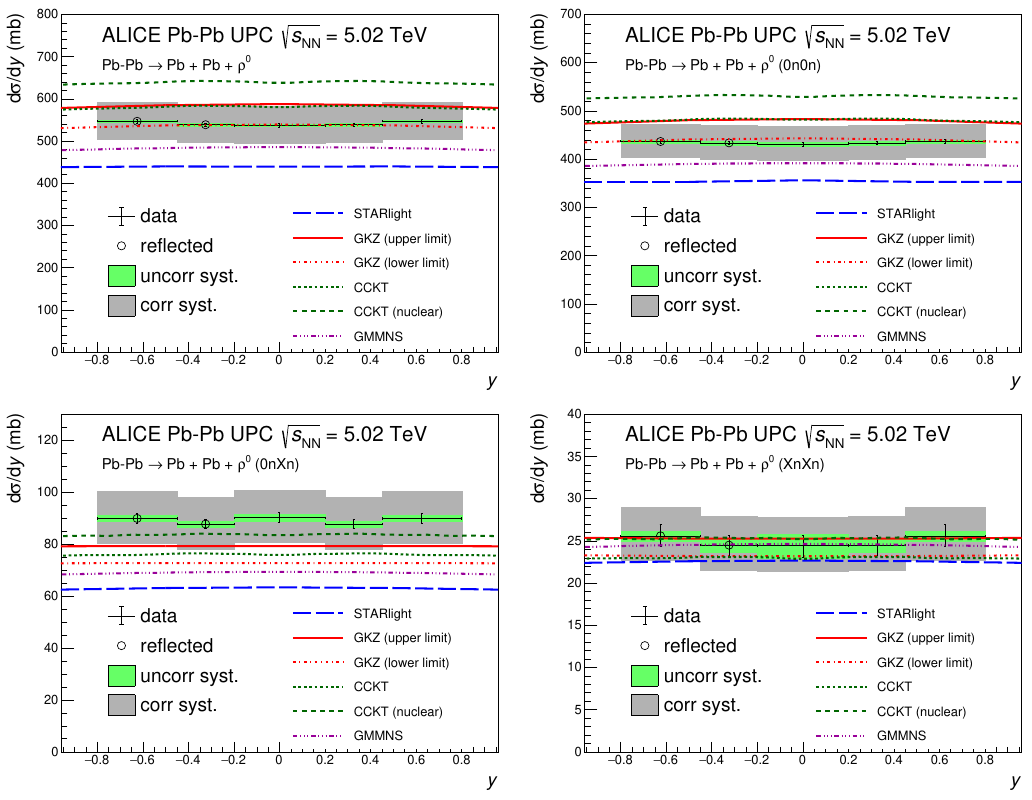
Figure 5 . (Colour online). Cross section for the coherent photoproduction of (cid:26) 0 vector mesons in Pb-Pb UPC as a function of rapidity for no forward-neutron selection (top left), and for the 0n0n (top right), 0nXn (bottom left) and XnXn (bottom right) classes. The lines show the predictions of the di(cid:11)erent models described in the